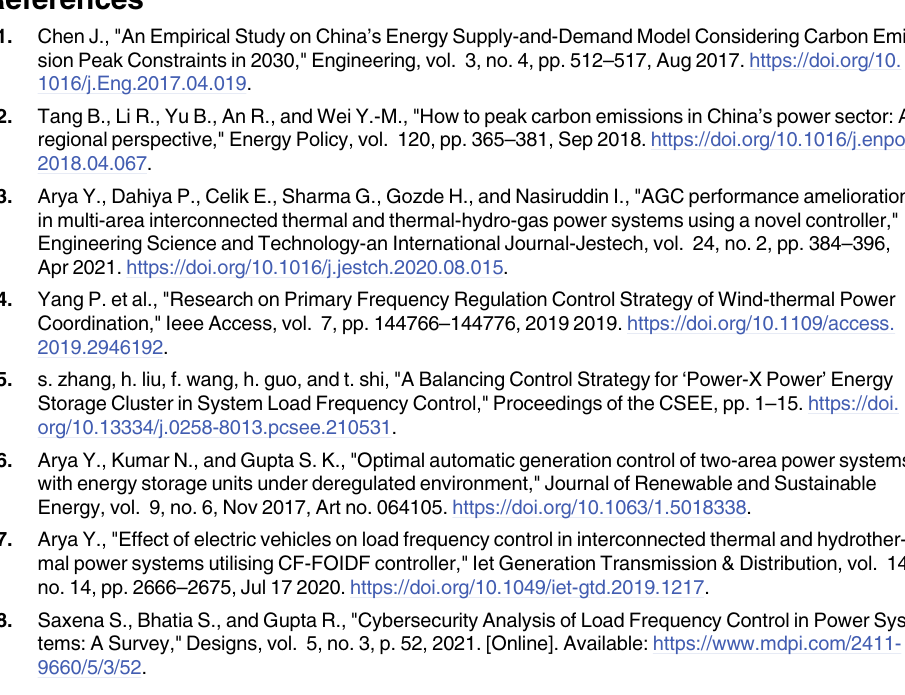
considered, using the situational awareness technology. Because traditional UFLS can easily cause power failures in one or more areas, precise load-shedding control will also be the focus of future research.